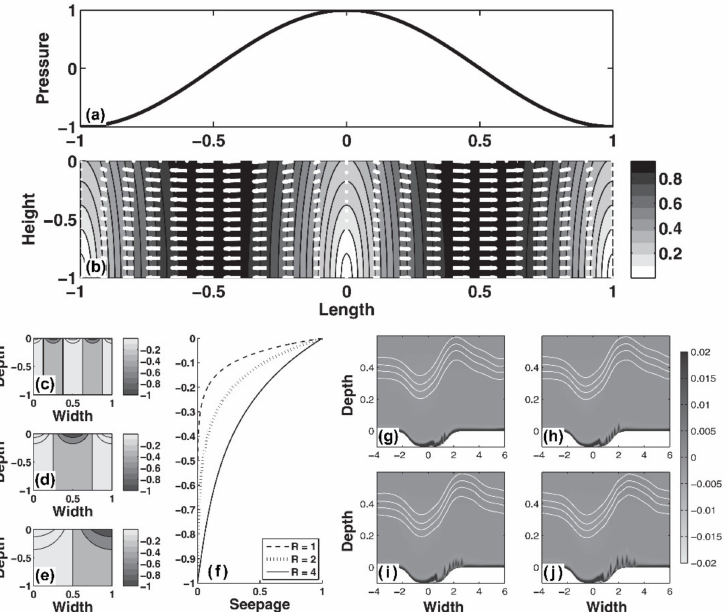
Figure 10. Seepage of pore fluid in lake sediment due to NLIWs propagating. ( a ) Normalized bottom pressure induced by NLIWs. ( b ) The contour of the normalized seepage. White arrows indicate the seepage direction. Normalized pore-pressure changes due to sinusoidal pressure forcing for wavelengths ( c ) R = 1, ( d ) R = 2, and ( e ) R = 4. Note the R gives the proportion of the horizontal scale, determined by the bottom pressure perturbation, to the depth of the seabed. ( f ) The seepage profiles for wavelengths R = 1, R = 2, and R = 4 under the wave trough. Evolution of the normalized